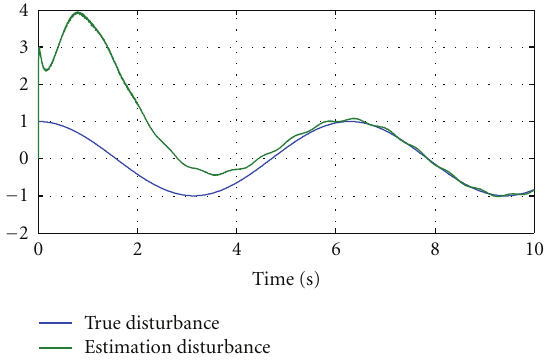
Figure 2: True and estimation values of disturbance for Example 5.